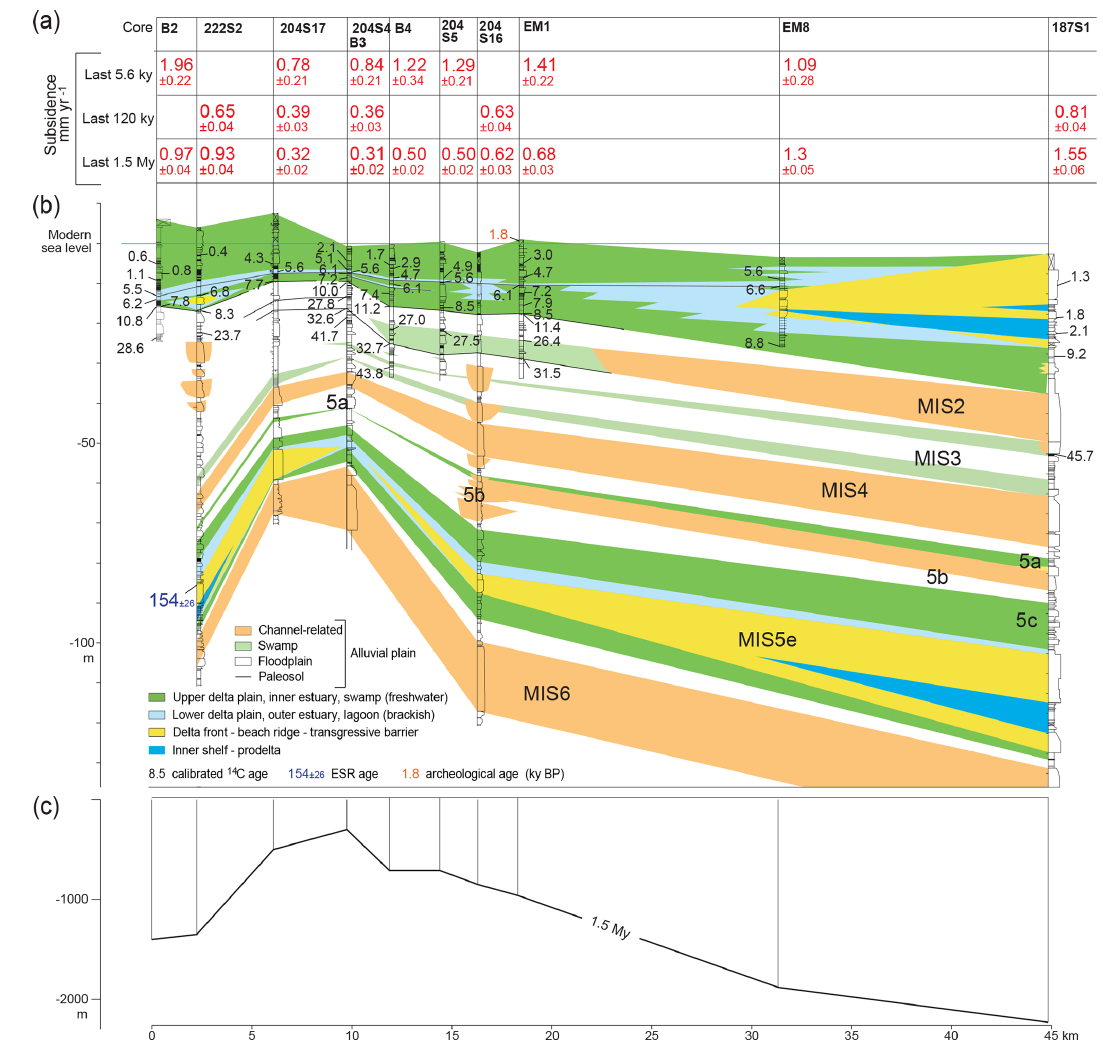
Figure 3. (a) Subsidence rates averaged over the last 5.6, 120 and 1500kyr; (b) core correlation of Late Pleistocene-Holocene deposits (see Fig. 1 for core location); (c) elevation of the 1.5MyrBP